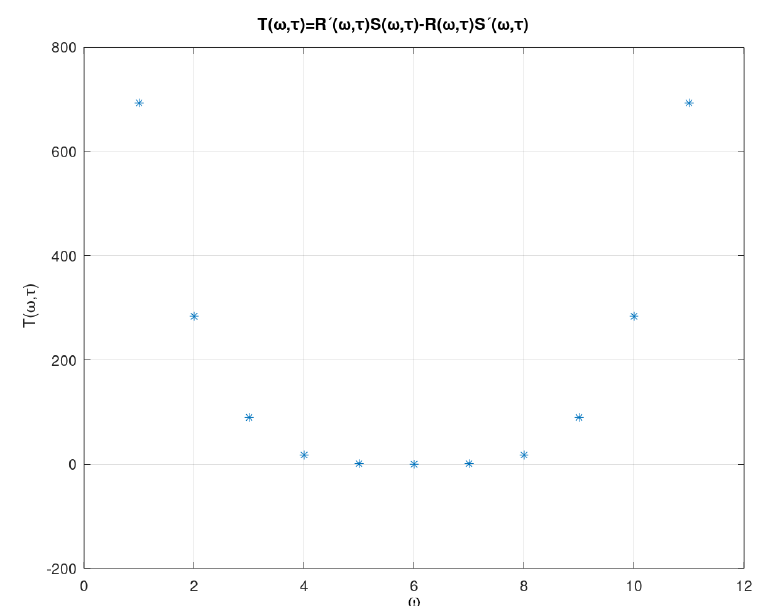
Figure 13. Quasi-characteristic polynomial.